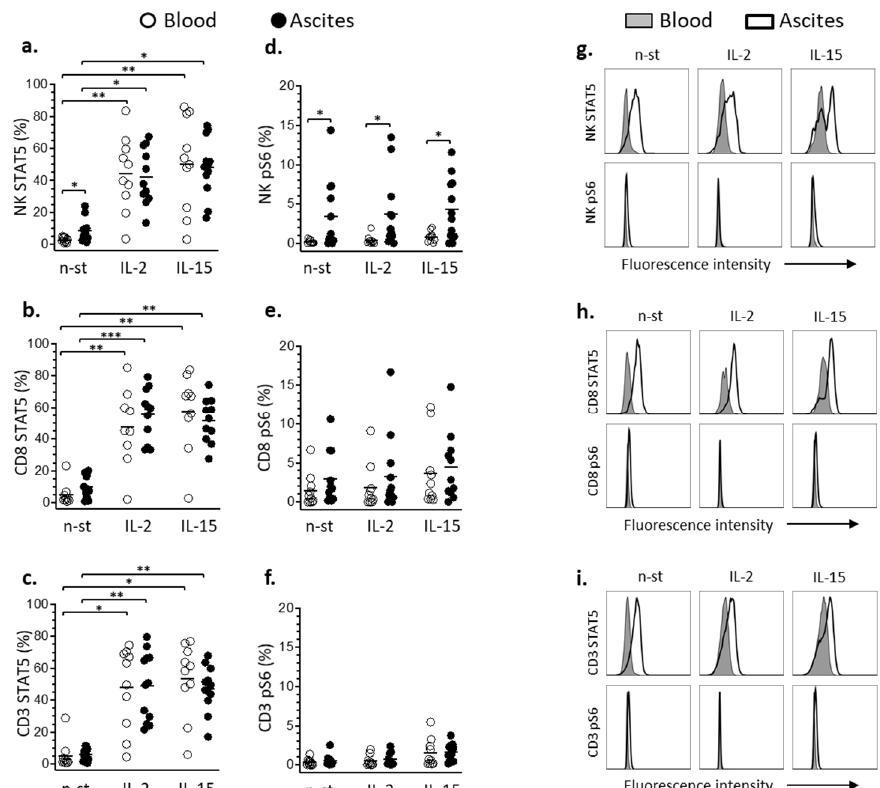
Figure 5. Comparison of phosphorylation of proteins STAT5 and pS6 in NK ( a , d ), CD8 ( b , e ) and CD3 ( c , f ) lymphocytes subsets from blood (white circles) and ascites (black circles) of women with advanced EOC. Protein phosphorylation was evaluated in non-stimulated (n-st) and after stimulation of blood and ascites cells with IL-2 (100 ng/mL, 30 min) or IL-15 (100 ng/mL, 45 min). Stimulation was conducted in RPMI-1640 medium supplemented with FBS (10%) and L-glutamine (2 mM). Values are presented as percentage of positive cells and mean. Statistical analyses were performed by ANOVA followed by uncorrected Fisher’s LSD multiple comparisons test and p -values (* p < 0.05, ** p < 0.01, *** p < 0.001 on the brackets) indicate significant statistical differences. Representative histograms comparing fluorescence intensities of STAT5 or pS6 phosphorylated proteins in NK ( g ), CD8 ( h ) and CD3 ( i ) lymphocytes from blood (gray) and ascites (white) of women with advanced EOC.